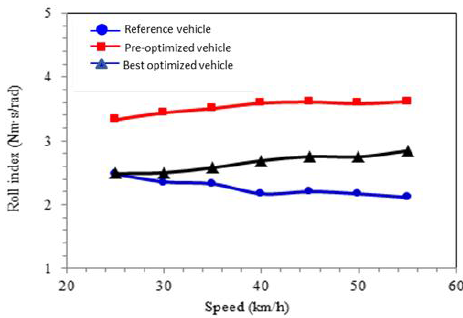
Figure 28. Simulated steering torque result on obstacle